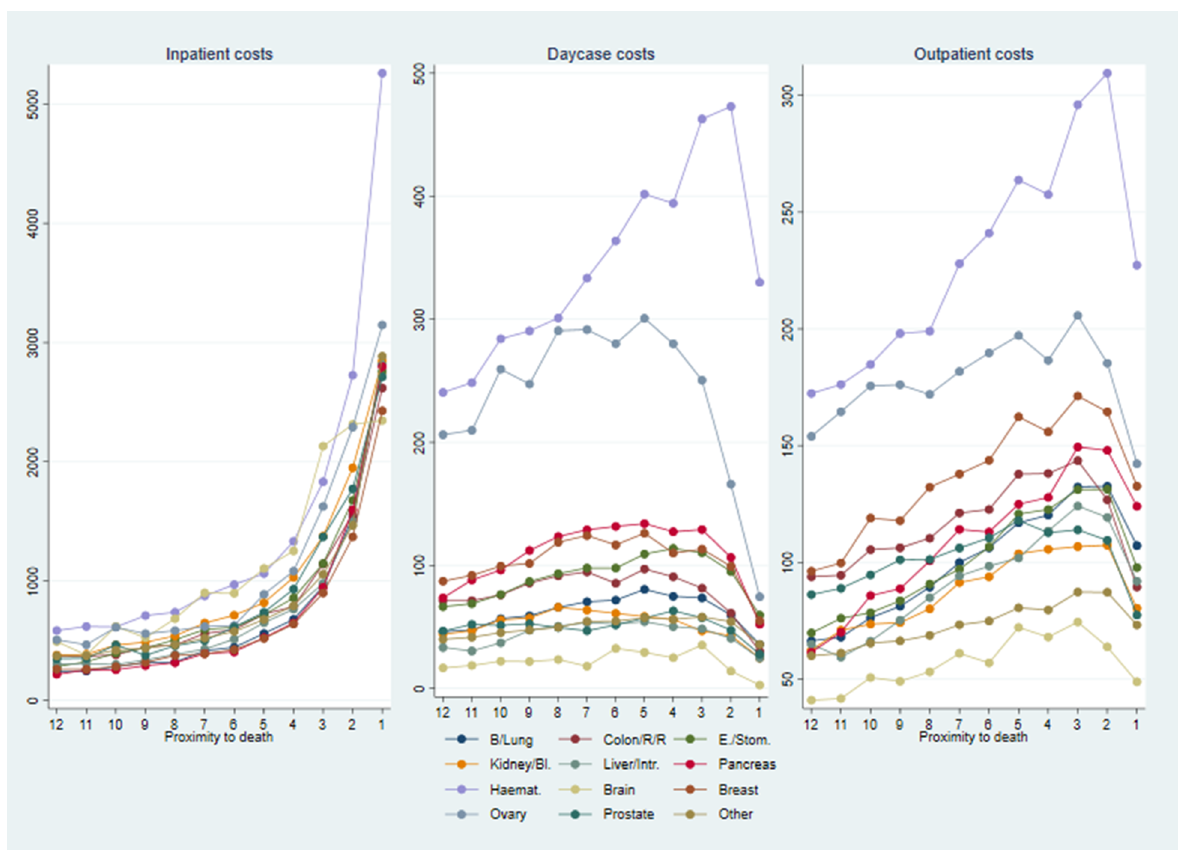
Other main: cancer not main cause of death; Bronchus/L:Bronchus and Lung cancer; Colon/R/R: Colon, Rectosigmoideum and Rectum cancer; Esoph/Sto.: Esophagus/Stomach; Liver/Intra.: Liver and Intrahepatic cancer; Kidney/Bl.: Kidney and Bladder cancer; Hemat.: Hematologic